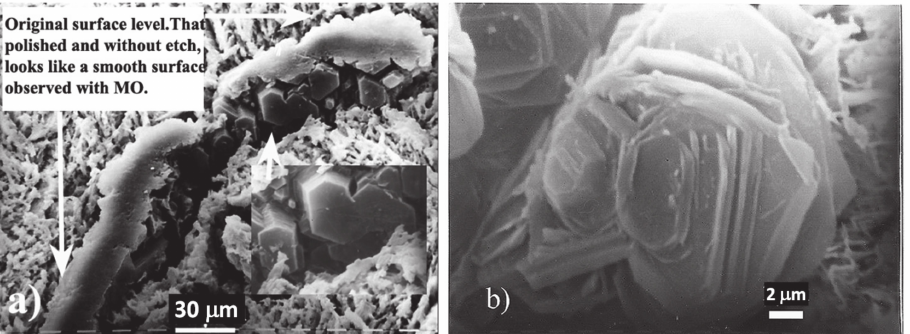
Figure 13. SEM images of: ( a ) CG from a grain boundary, showing noticeable faceted aspect in deep etched lateral walls. Instead, the upper plane looks much more rounded; ( b ) foliated dendrites with two helix dislocations emerging on basal